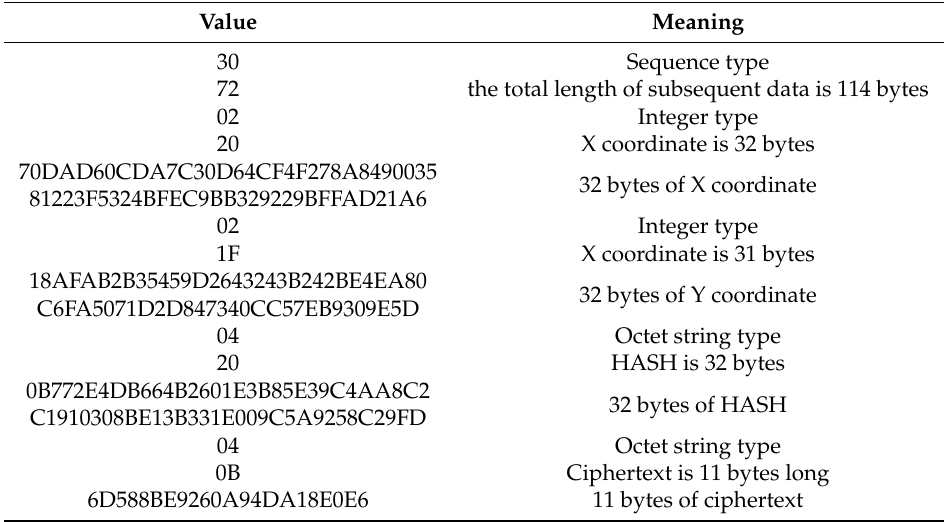
Table 8. Comparative analysis of the model.